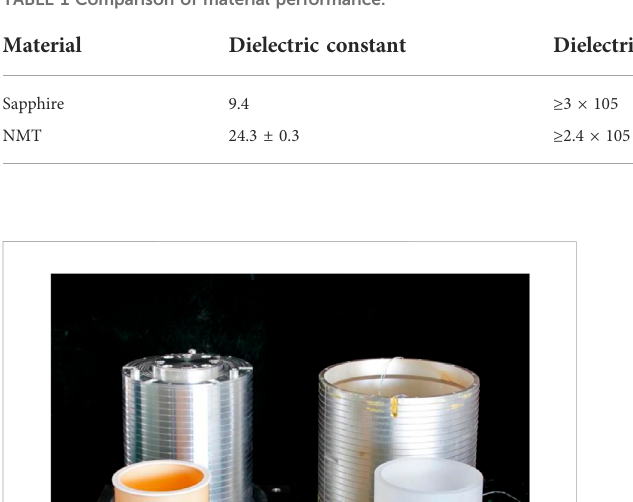
TABLE 1 Comparison of material performance.